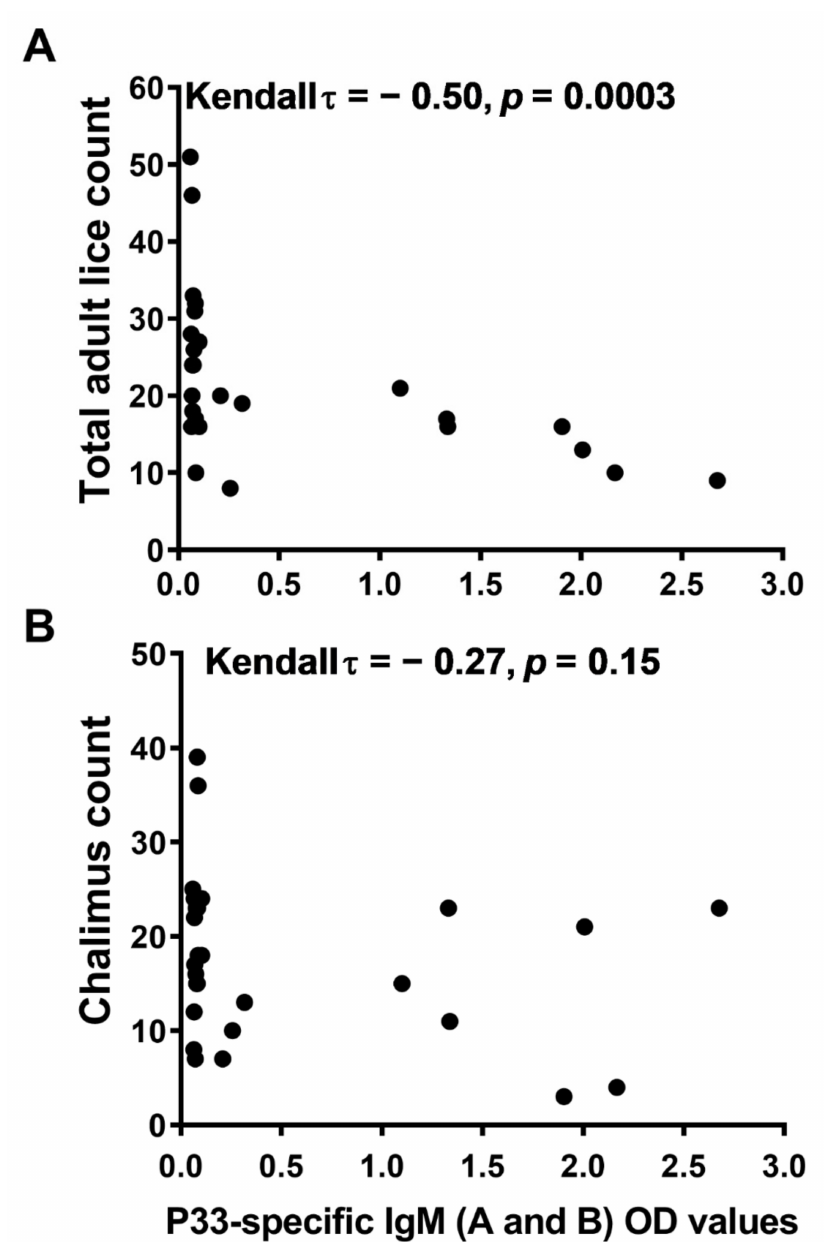
Figure 9. Adult lice count correlates negatively with P33-specific IgM levels in salmon plasma after P33 vaccination. Scatter plot of lice count versus P33-specific IgM (A and B subtypes) levels in blood plasma (OD values by ELISA; x -axis), showing the correlation between P33-specific IgM (A and B subtypes) OD values in the plasma of mock-vaccinated (injected with phosphate-buffered saline [PBS]) and P33-vaccinated (high dose [HD]) Atlantic salmon at 18 weeks post-vaccination [wpv], and the lice count on the same fish. ( A ) Scatter plot of total adult lice count (18 wpv); ( B ) Scatter plot of chalimus count (16 wpv). Kendall’s rank correlation coefficients ( τ ) and p values are shown on the